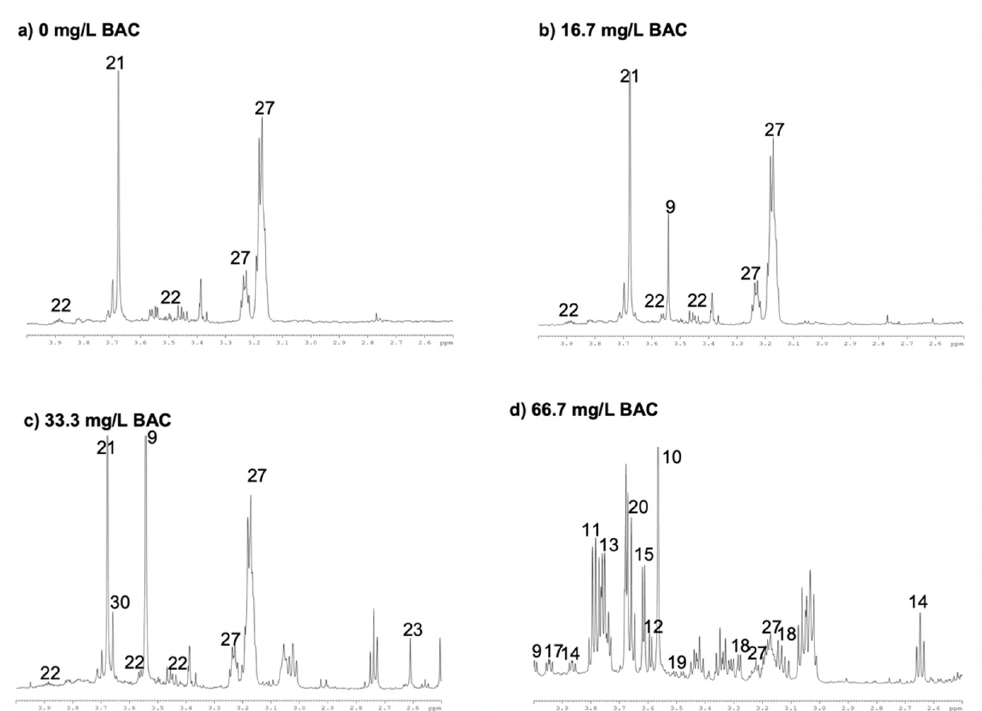
Figure 2. The alkyl region of the 1 H NMR spectra microcosm samples after 18 days of BAC exposure for ( a ) 0 mg/L BAC, ( b ) 16.7 mg/L BAC, ( c ) 33.3 mg/L BAC, and ( d ) 66.7 mg/L BAC. Peaks for con- firmed structures are numbered and are identified in Table 1.